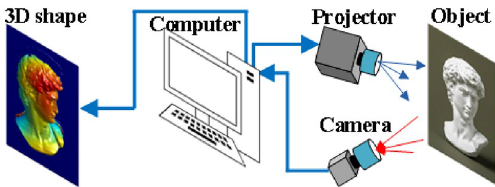
Figure 7. Structure of the 3-D measurement system.